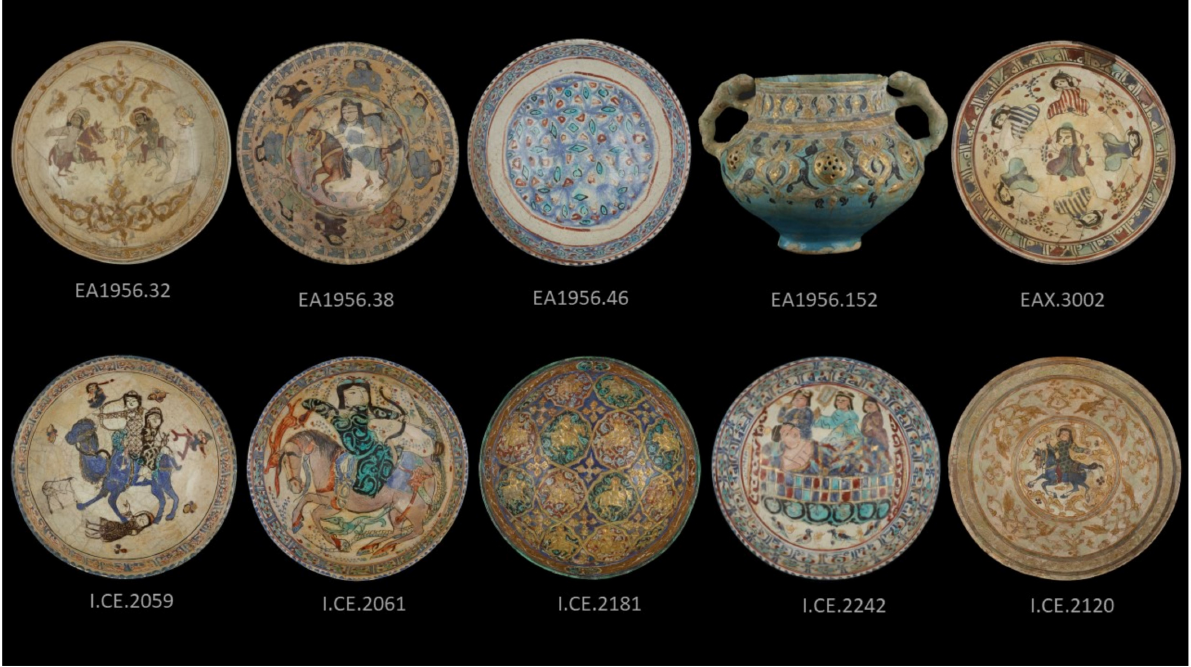
Figure 1. Upper row are objects from the Ashmolean Museum of Art and Archaeology, University of Oxford. Additional views of EA1956.22, EA1956.152, and EAX.3002 are available on the museum website [11–13]. The second row are objects from the Sarikhani Collection; see Watson 2020 [10] (pp.